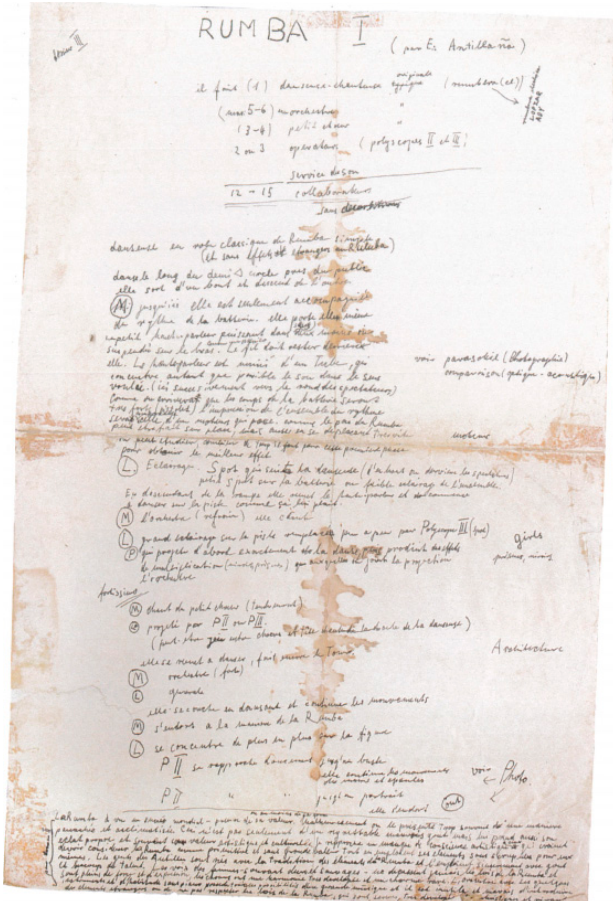
Figure 1. Wols, Circus Wols: Rumba I . Music show conceived at the Camp des Milles, 1940. Private collection. © Adagp, Paris, 2020.